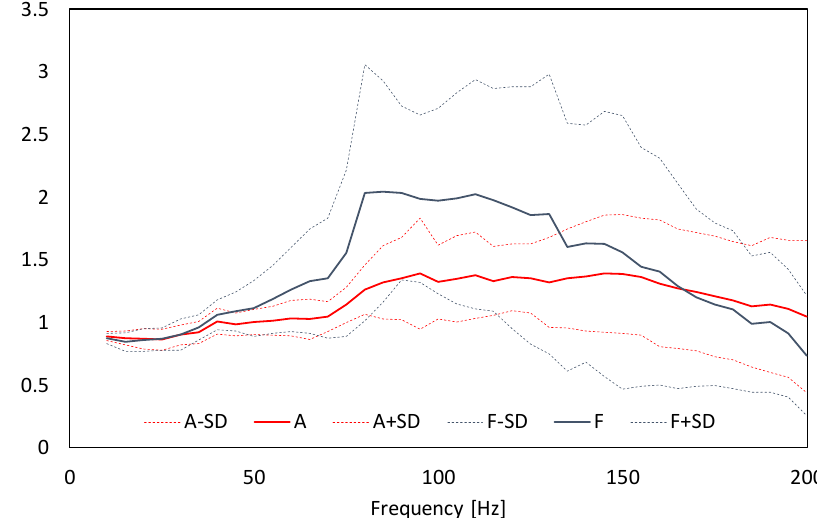
Figure 5. Transmissibility (average transmissibility for the 20 participants ± SD) of materials A and F measured at the position T1P1.